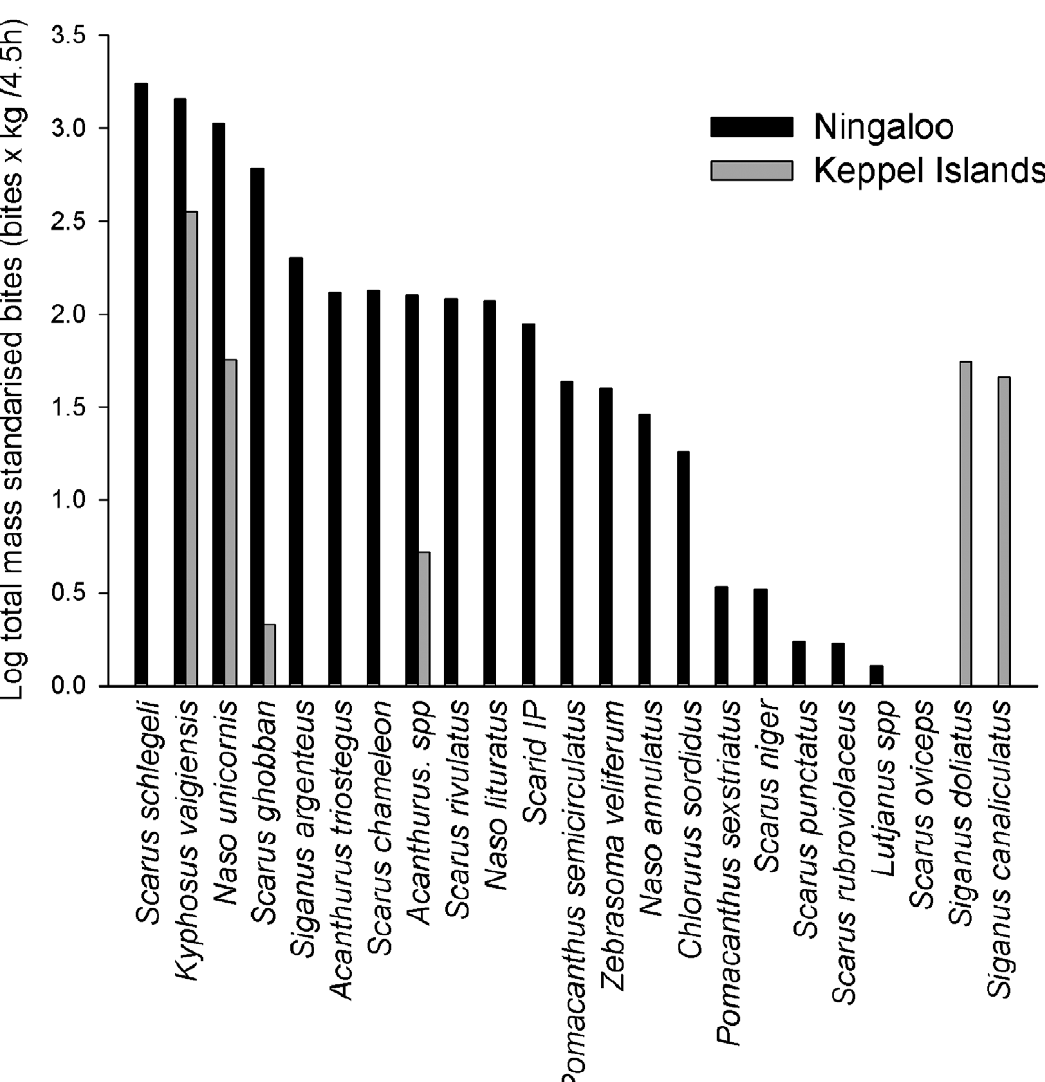
Figure 2. Total number of mass standardised bites (log transformed) taken by of the herbivorous fish assemblages feeding in each region over 4.5 hours